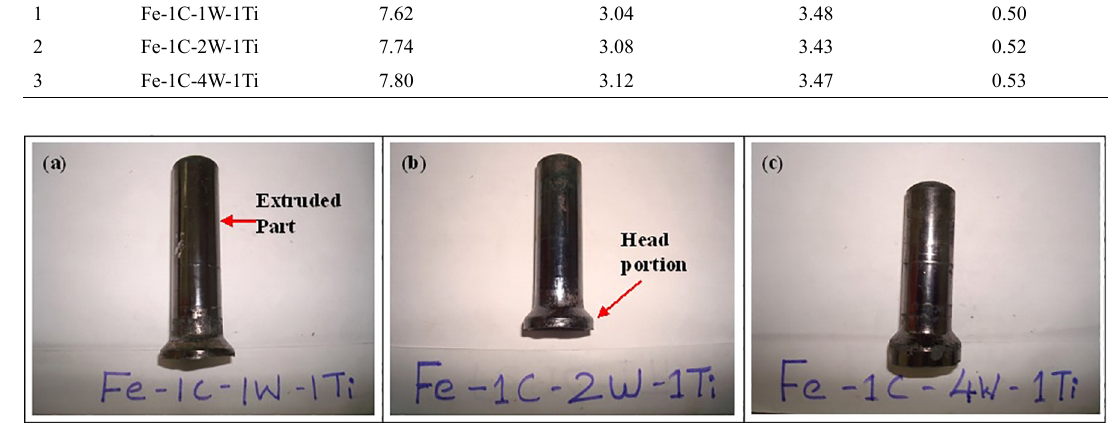
Table 1. Physical properties of elemental alloy powder Sl. No.